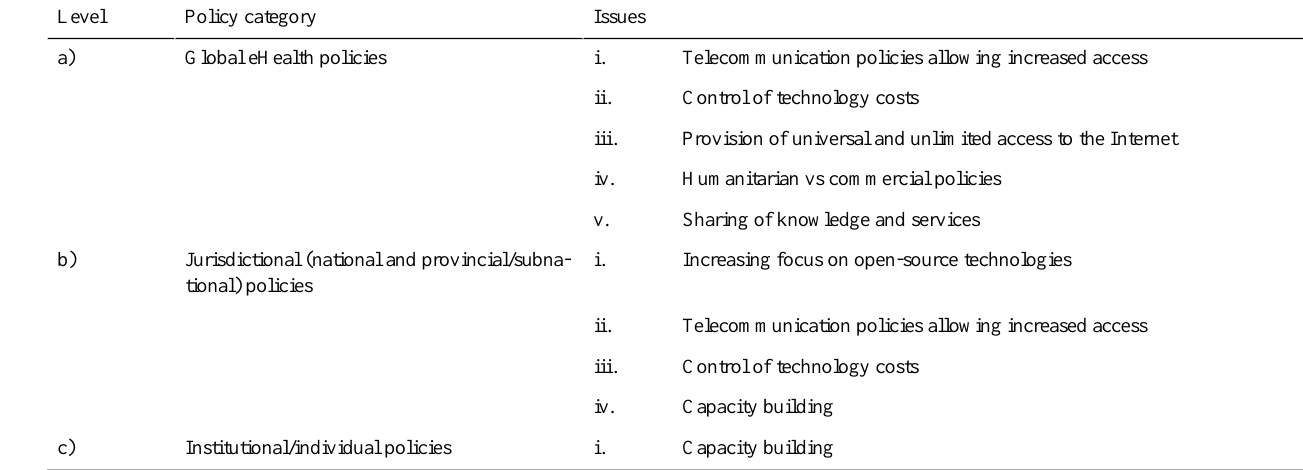
Table 3. Diffusion of eHealth/digital